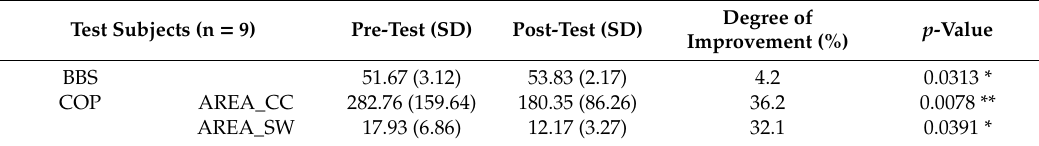
Table 2. The results of the group exercise with modular interactive tiles (MITs) before and after the 12-week training